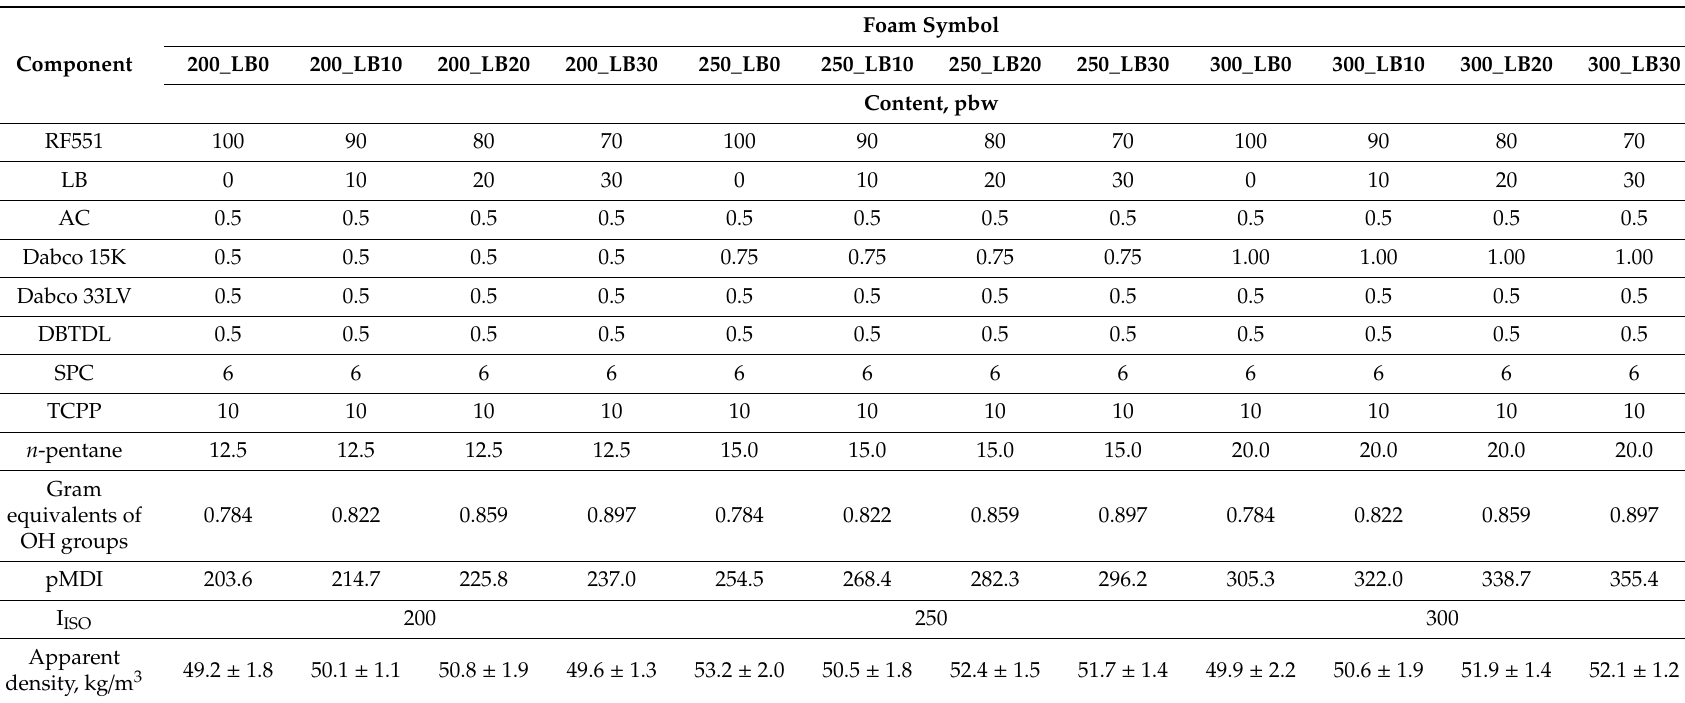
Table 2. Formulations of prepared polyurethane-polyisocyanurate (PUR-PIR) foams. DBTDL, dibutyltin dilaurate; TCPP, Trichloropropyl phosphate; pMDI, polymeric methylene